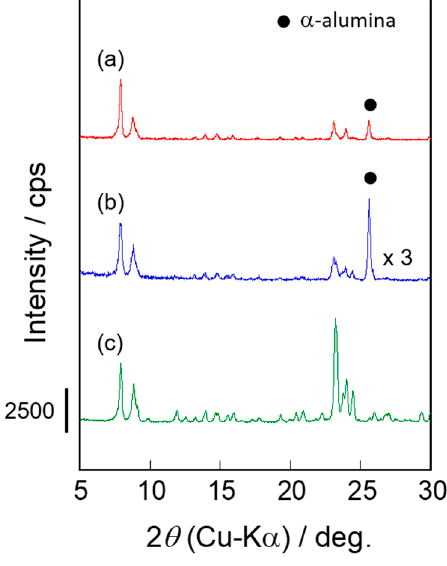
Figure 2. XRD patterns of silicalite-1 ( a ) S-1 S , ( b ) S-1 M and ( c ) silicalite-1 powder.